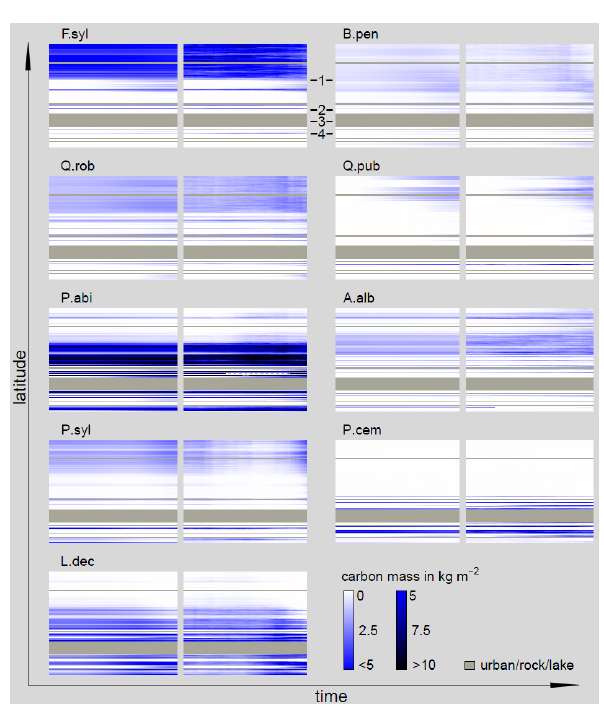
Figure 4. Total carbon mass simulated with the adjusted and the standard parameter set, both using GAPPARD, for (a) 2000 and (b) 2100. Total carbon mass changes between (a) and (b) are displayed in (c)